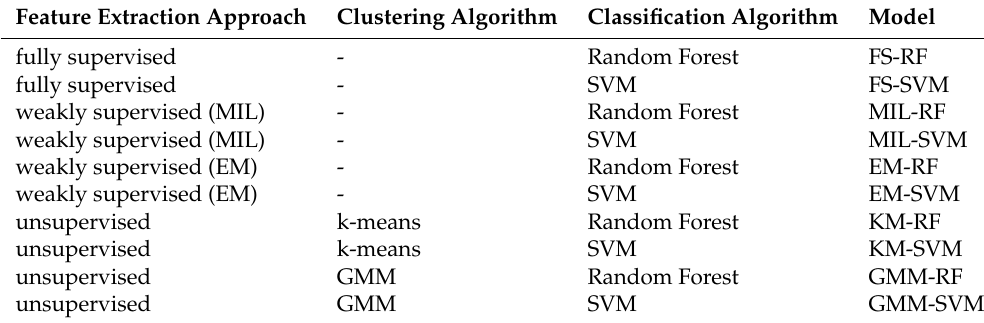
Table 1. Summary of